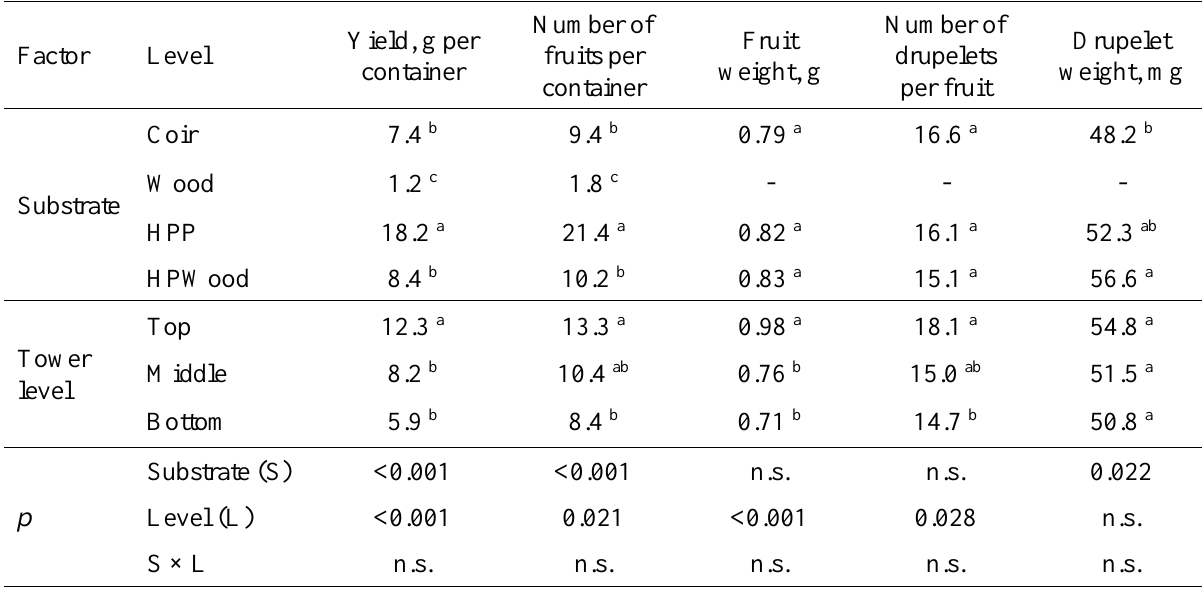
Table 4. Mean fruit yield, number of fruits per container, mean fruit weight, number of drupelets per fruit and drupelet weight of arctic bramble plants grown in different substrates and on different levels in plant towers. Different superscripts indicate statistically significant differences between the means within each factor by Tukey’s test (P < 0.05). n.s. = not